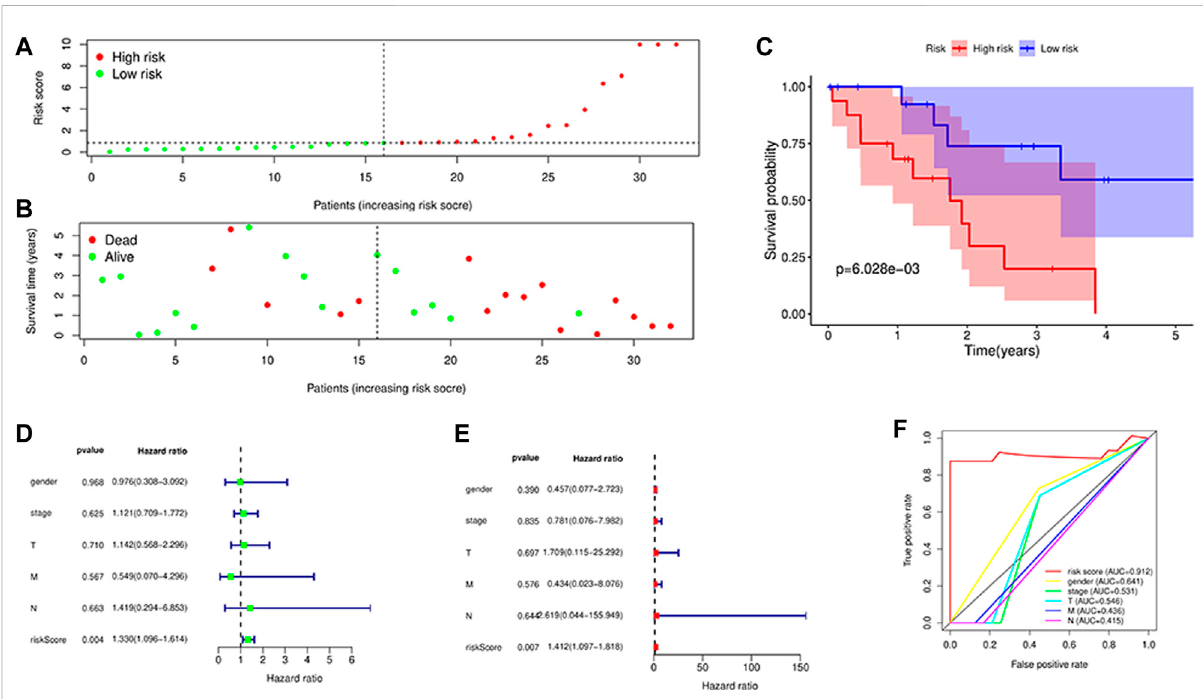
FIGURE 7 Survival analysis. (A,B) : Distributions of risk scores and survival status, Survival was longer in the low-risk group than in the high-risk group; (C) : Kaplan – Meier curves for the High risk and low risk patients. The survival curve showed low survival in the high-risk group; (D,E) : Univariate (D) and multivariate (E) Cox regression analysis in the simultaneously demonstrated the independent prognostic value of the risk score; (F) : ROC curves for predicting risk score, gender,stage,T, M, N